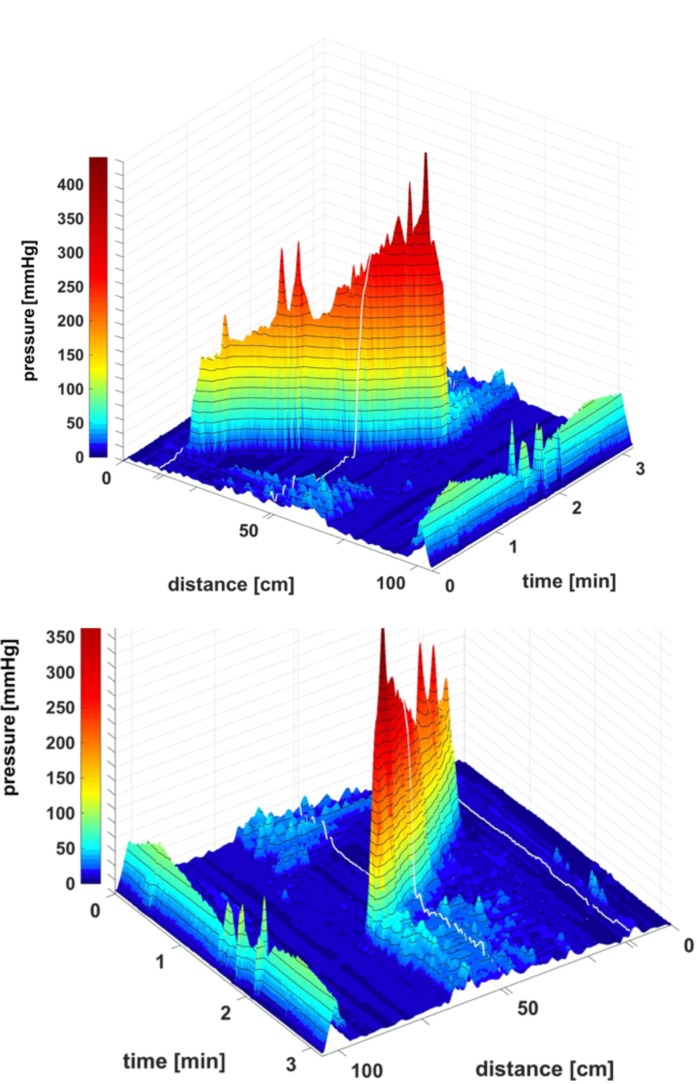
An HAPW that was not followed by an SPW, was not associated with anal sphincter relaxation. Most HAPWs that are associated with anal sphincter relaxation terminate into an SPW that enters the anal canal. In this subject, an HAPW that terminated suddenly and was not followed by an SPW and did not evoke anal sphincter relaxation. This motor pattern occurred 4 min into a proximal balloon distention (240 ml air). The motor pattern started distal to the balloon distention.